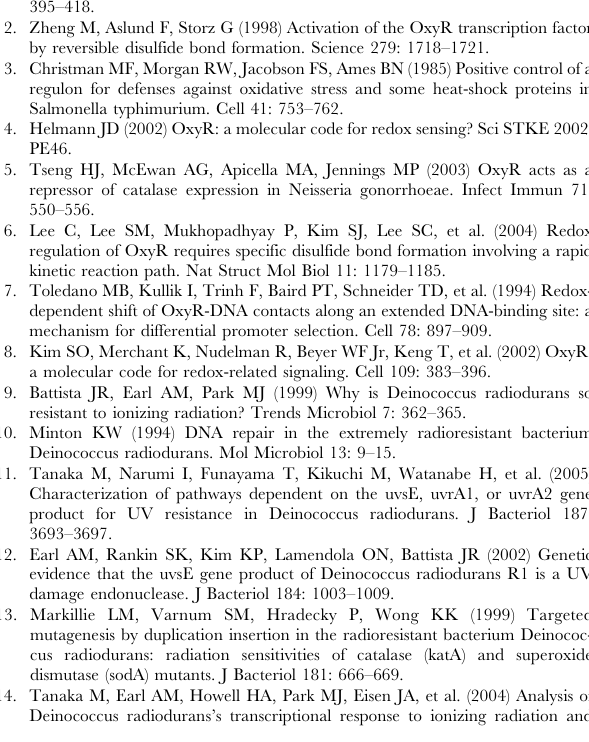
Table S2 The induced genes showed in MOxyR. All genes are sorted by fold induction or repression. Table S3 Functional classification of genes with statistically significantly induction or repression in untreated wild-type strains compared to untreated oxyR